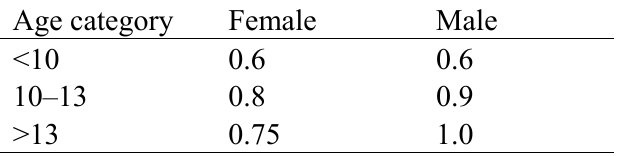
Table 1. Adult equivalent conversion.